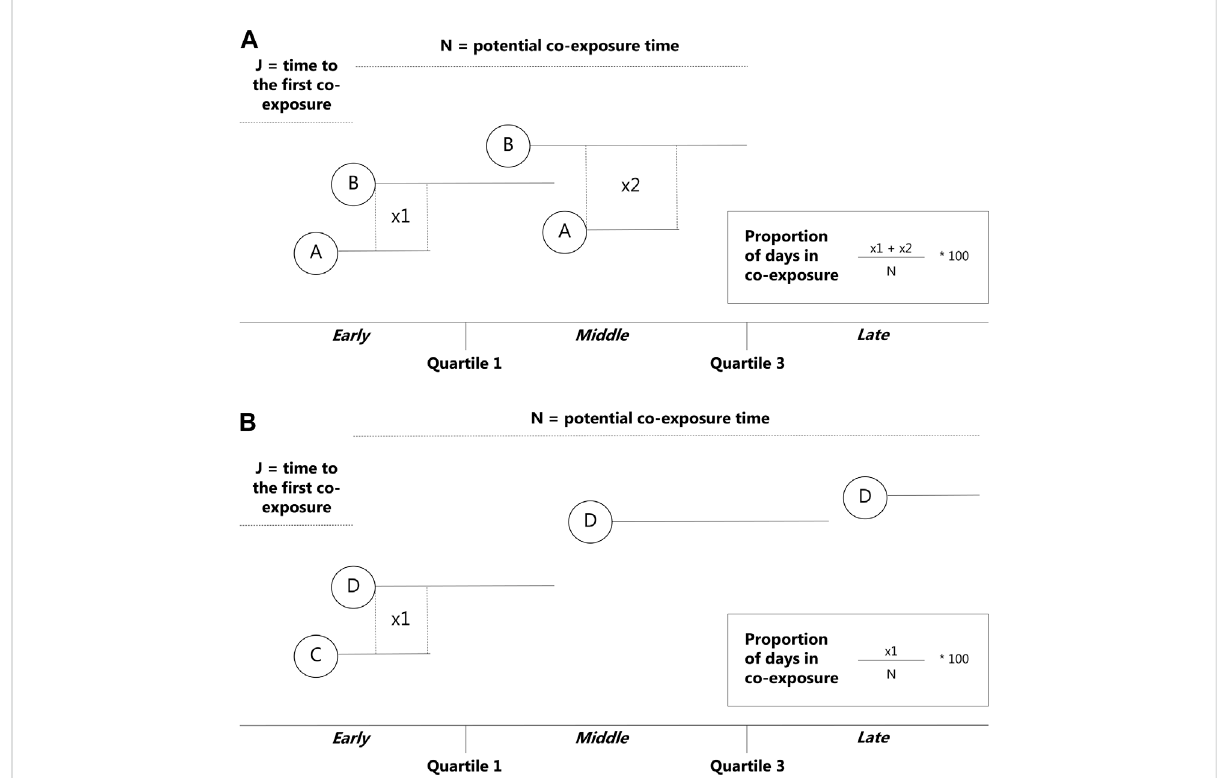
FIGURE 1 Overviewofthenewlydevelopedalgorithm — add-ons.N=potentialco-exposuretimefromthebeginningoftheredeemedprescriptionofthe second medication to the end of the follow-up period, J = time to the fi rst co-exposure from the beginning of the observational window, used to determine which stage the co-exposure occurred in. (A) = drug 1, (B) = drug